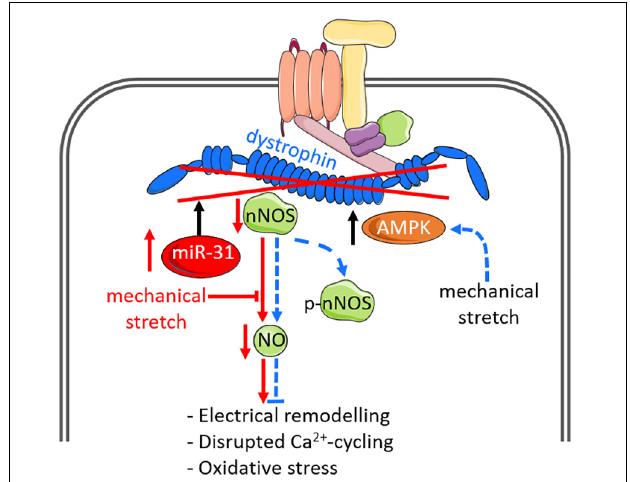
FIGURE 2 | Nitric oxide signaling and mechanical stimuli affect dystro-sarcoglycan complex function and can modify disease pathology. Dystrophin is the largest component of the dystrophin-glycoprotein complex (DGC), and closely associates with neuronal nitric oxide synthase (nNOS). Loss of dystrophin, via upregulation of microRNA-31 or genetic mutations, leads to disassociation of nNOS from the DGC and impairs NO production. Loss of NO is associated with atrial electrical remodeling, disrupted Ca 2 + cycling and oxidative stress. The DGC additionally acts as a mechano-sensor to regulate NO signaling. In normal cardiomyocytes in which dystrophin is intact (indicated by dashed blue lines), mechanical stretch enhances NO production via enhanced AMP-activated protein kinase (AMPK) activation and phosphorylation of nNOS-serine 1412 (p-nNOS), which increases nNOS activity. Such downstream effects by mechanical stretch are impaired in dystrophin-deficient cardiomyocytes. The impact of dystrophin-deficiency on NO production are indicated by solid red